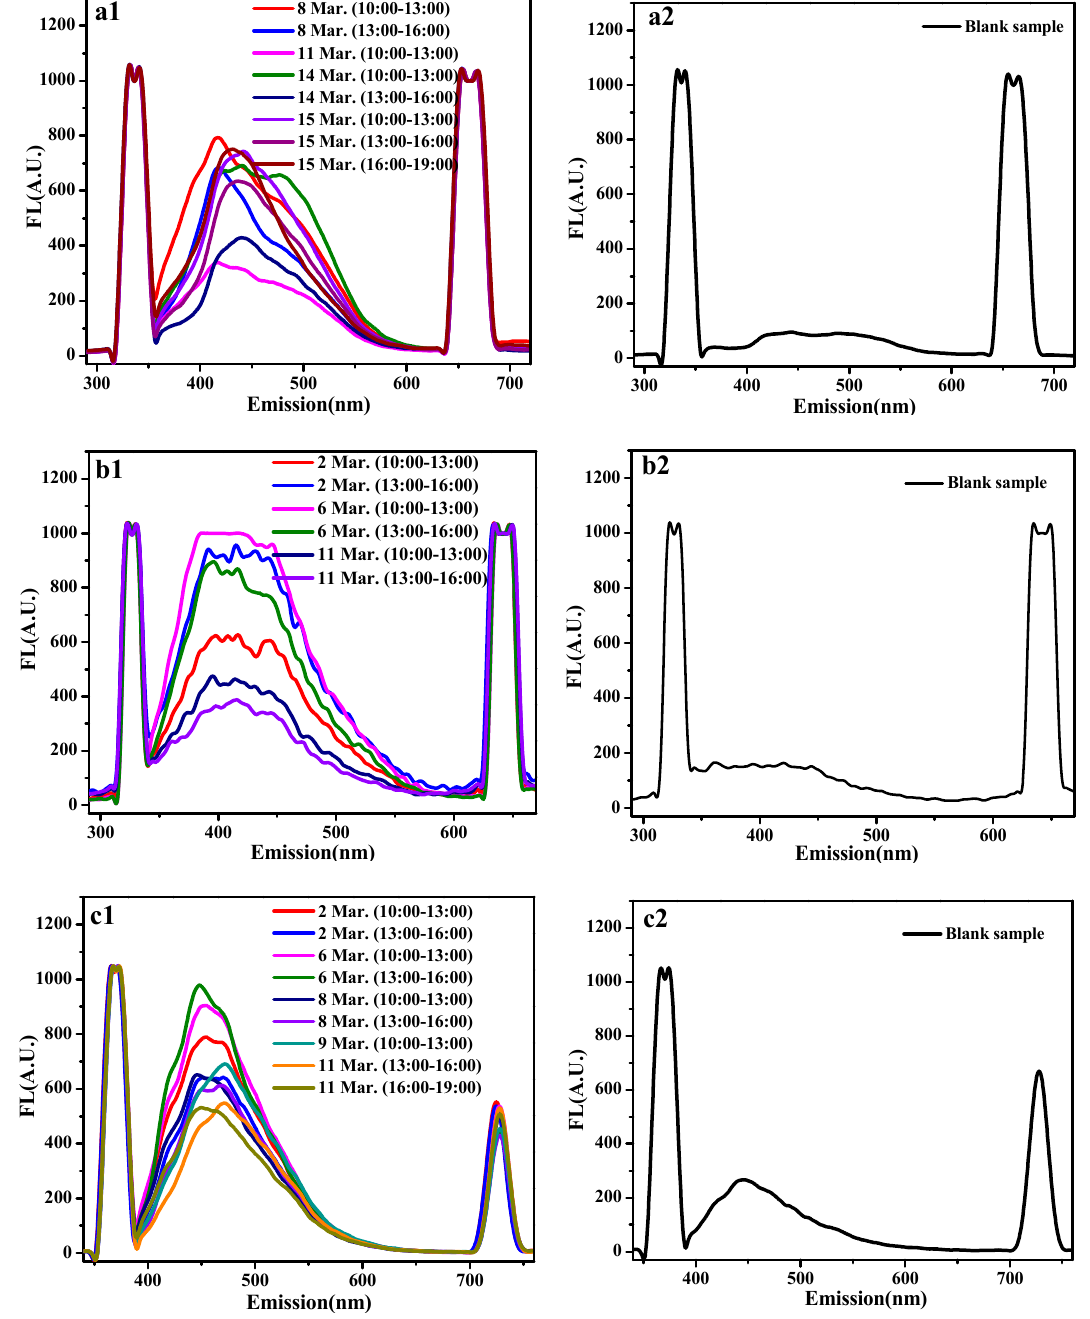
Figure 9. The fluorescence intensity variation of three molecules after and before sampling ( a : quercetin, b : glycyrrhizic, c : α -mangostin). Table 7. The RSD for three active molecules with different methods.